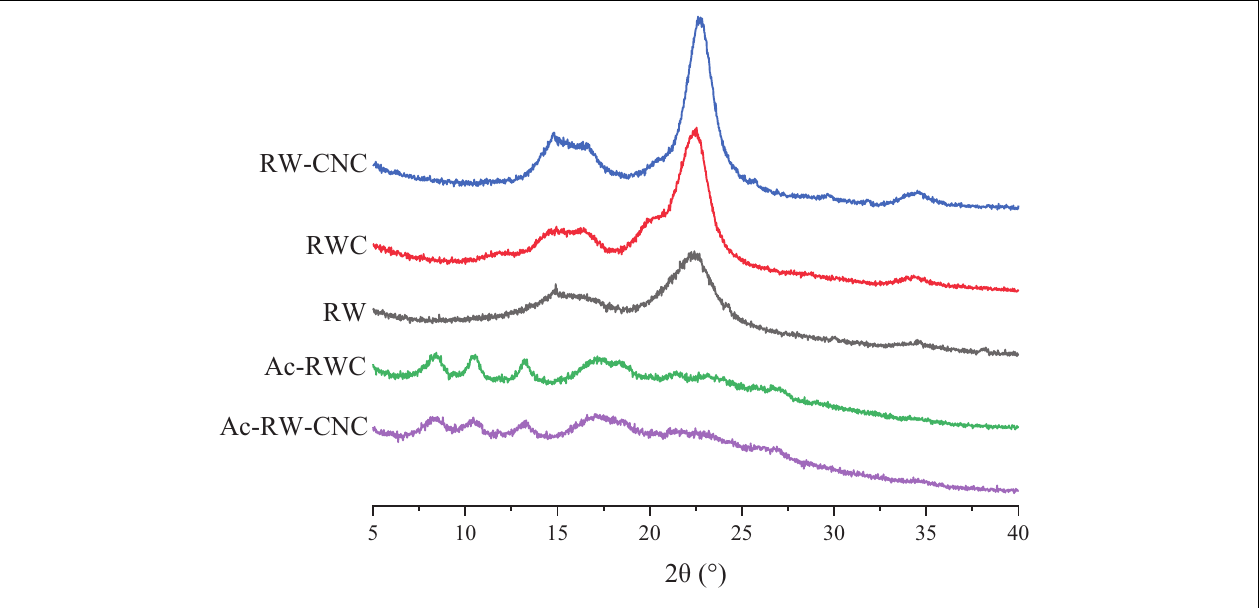
FIGURE 3 | X-ray diffraction patterns of RW, RWC, Ac–RWC, RW–CNC, and Ac–RW–CNC. RW–CNC was successfully prepared from RWC via 64